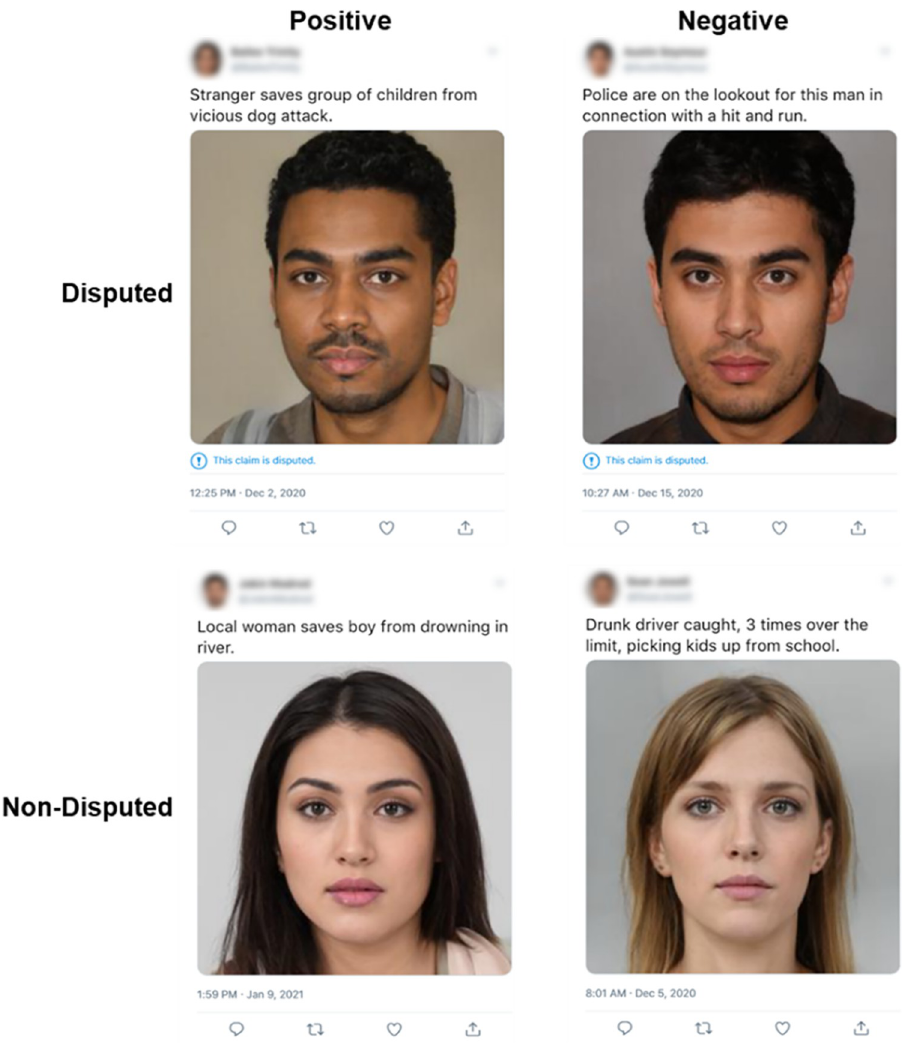
Fig 1. Example tweet stimuli. Stimuli encountered by participants during the study phase. Face stimuli taken from Generate Photos (https://generated.photos/datasets) and tweets created in